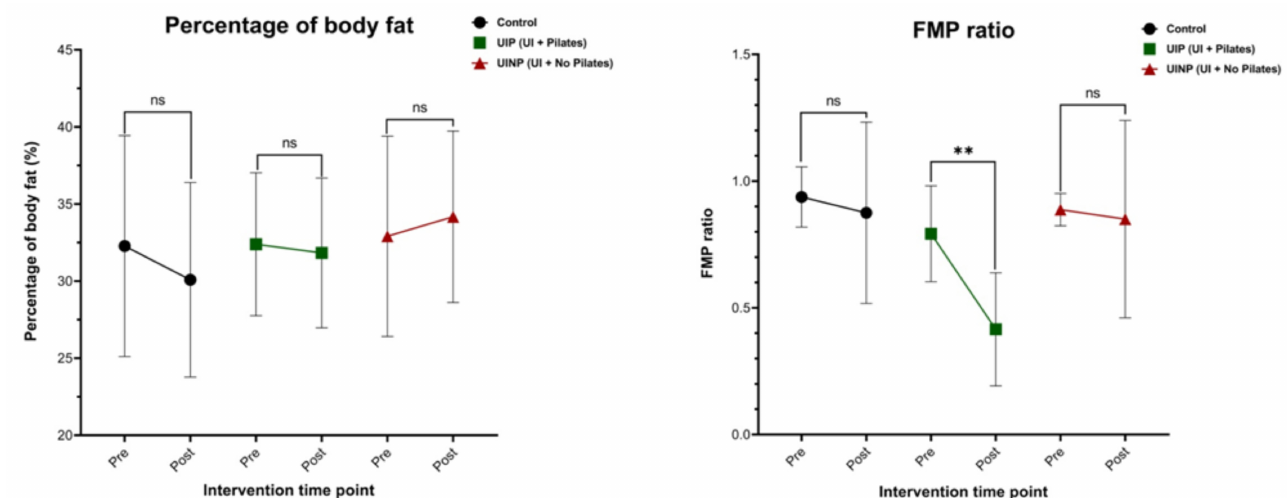
Figure 6. Change of anthropometrical data and FMP ratio between Pre- and Post-intervention in Control, UIP, and UINP. Control: control group; UIP: urinary incontinence group with Pilates; UINP: urinary incontinence group with no Pilates; FMP: functional movement of PFM; FMP ratio: calculated ratio where the movement distance of bladder base during PFM contraction state is divided by that during PFM resting state, contraction/resting state; pre: before 8-weeks intervention; post: after 8-weeks intervention. ** ( p < 0.001): Significantly different from Pre. ns means